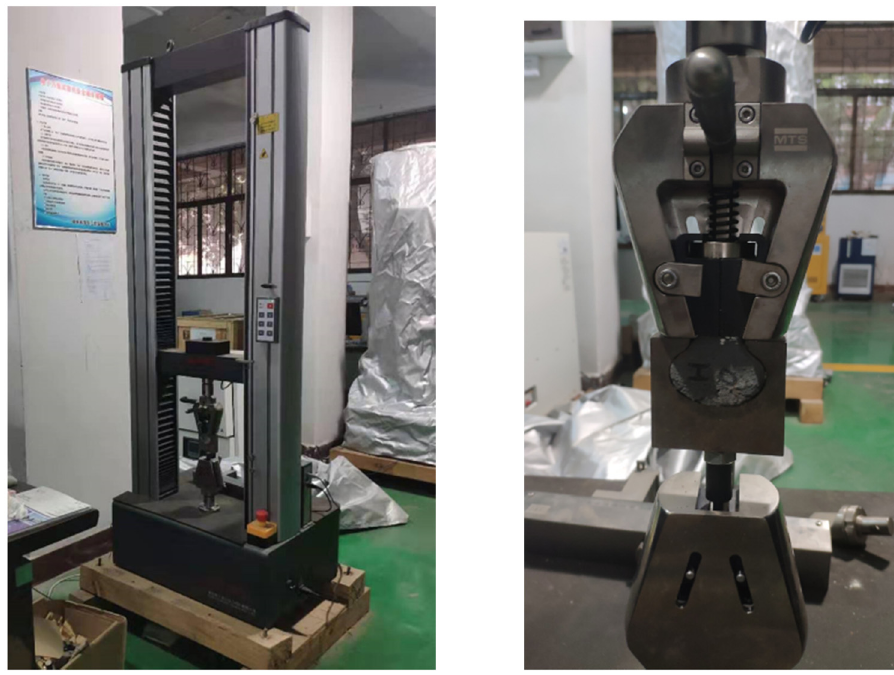
Figure 2: Setup of single fi ber pullout